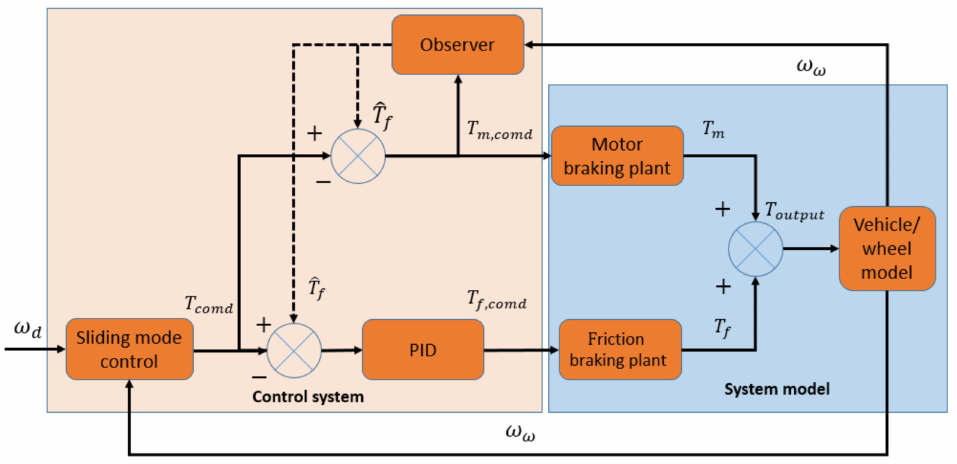
Figure 12. PID for braking torque